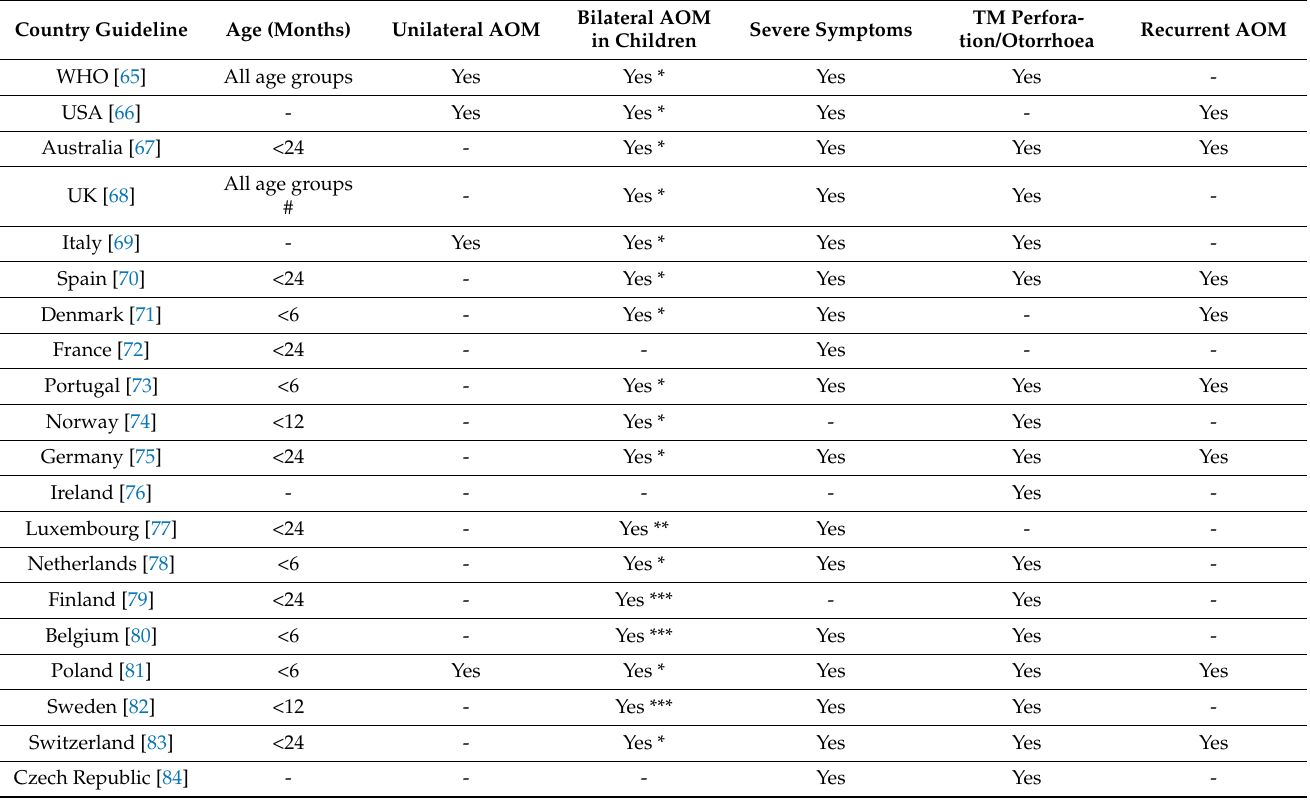
Table 3. Indications for immediate antibiotic